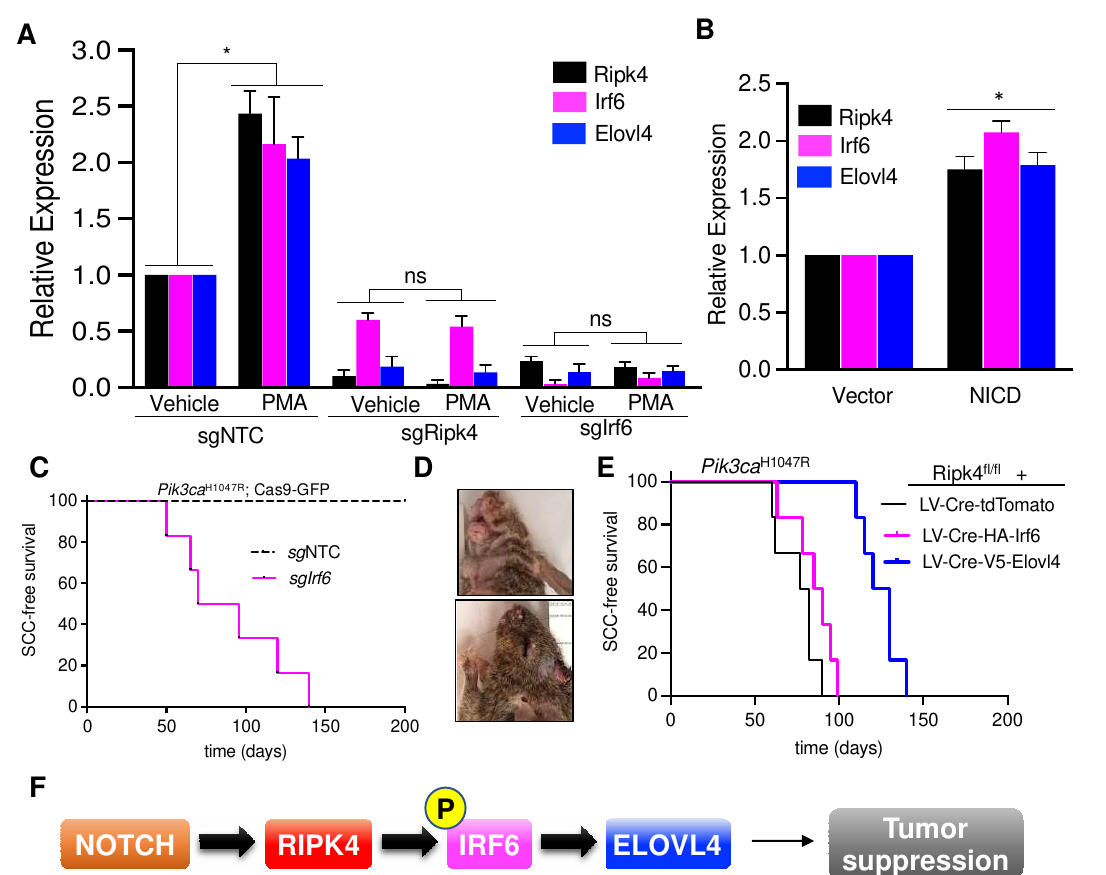
Figure 4. Notch-Ripk4-Irf6-Elovl4 tumor suppression axis. ( A ) Real-time PCR results showing relative expression of Ripk4, Irf6, and Elovl4 genes in the mouse keratinocytes transduced with LV targeting sgRipk4, sgIrf6, or sgNTC treated with either vehicle or PMA (phorbol 12-myristate 13-ace- tate). Data are shown as mean ± SEM ( n = 3). * Denotes p -value < 0.05 (ns = not significant). ( B ) Relative expression of Ripk4, Irf6, and Elovl4 genes in the mouse keratinocytes transfected with